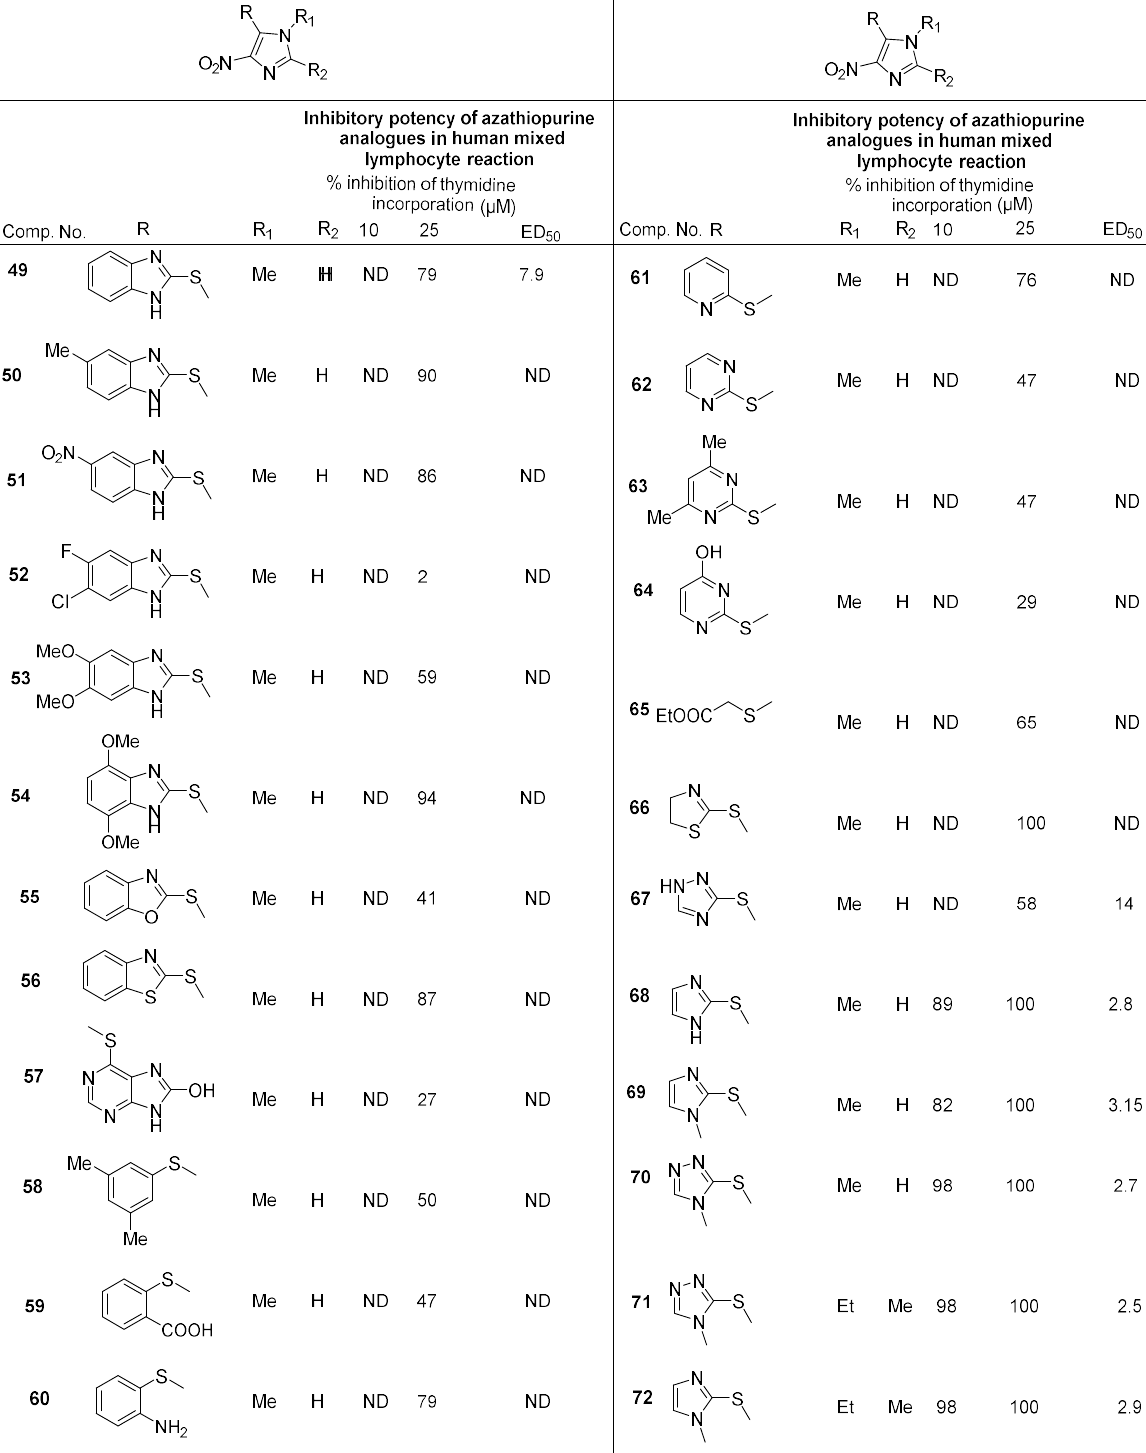
Figure 10. Inhibitory potency of Azathioprine analogs in a human-mixed lymphocyte reaction.